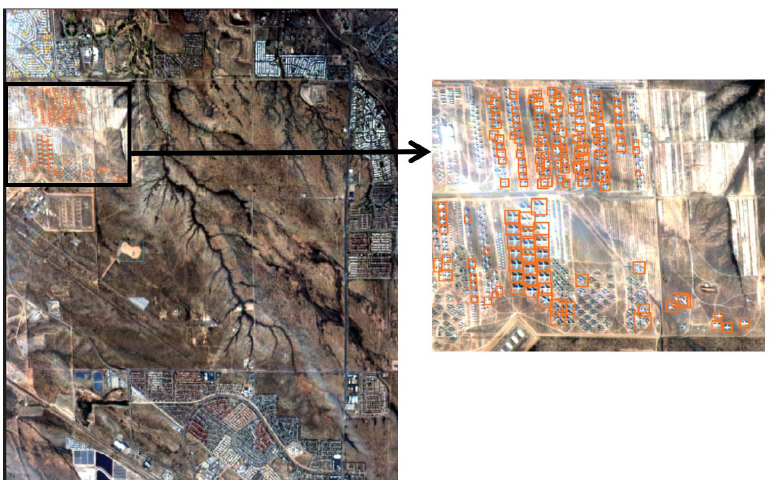
Figure 12. The detection performance for aircraft with modified Yolov5 in the original satellite im- age.